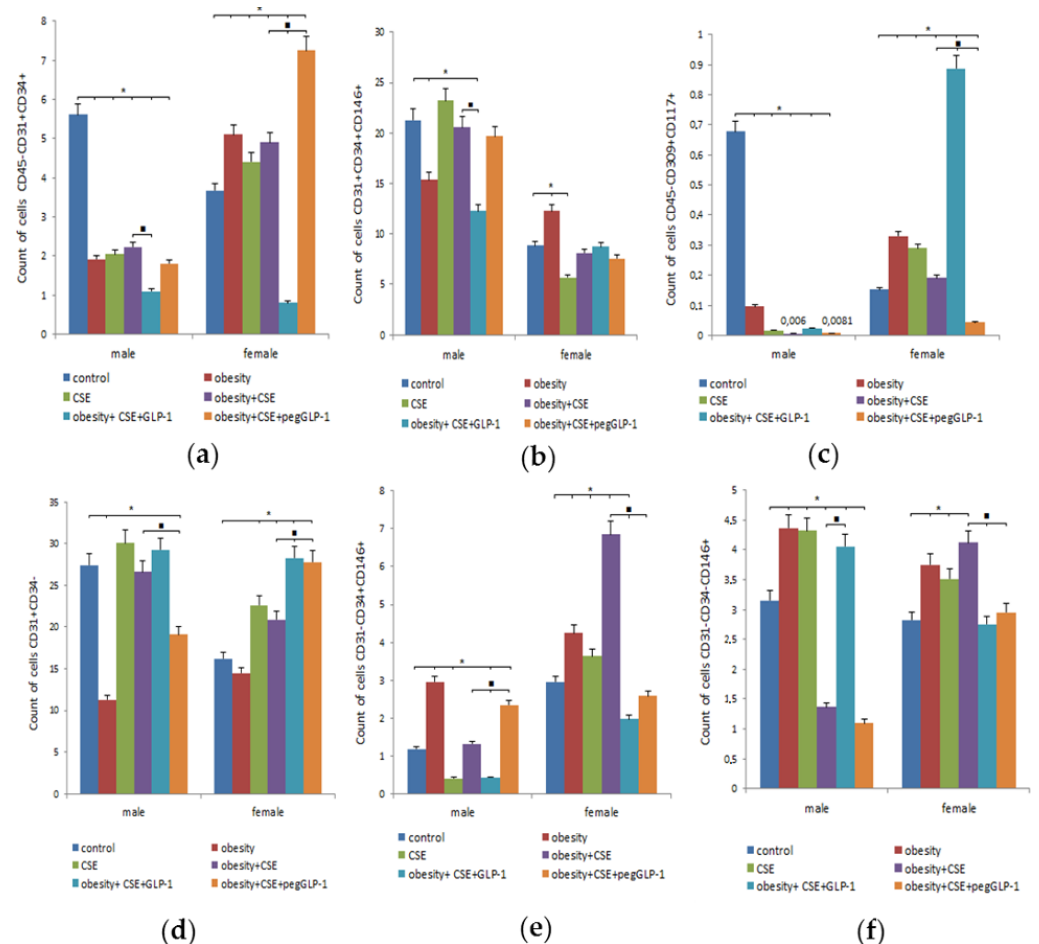
Figure 6. Characterization of cell population isolated from the lung of male and female C57BL / 6 mice on the p189. ( a ) The content of endothelial progenitor cells (EPC) (CD45 − CD31 + CD34 + ); ( b ) The content of EPC (CD31 + CD34 + CD146 + ); ( c ) The content of angiogenesis precursors (CD45 − CD309 + CD117 + ); ( d ) The content of cells in the lumen of the nascent vessel (CD31 + CD34 − ); ( e ) The content of vascular smooth muscle cells (CD31 − CD34 + CD146 + ); ( f ) The content of pericytes (CD31 − CD34 − CD146 + ). Cells were analyzed by flow cytometry using antibodies for CD31, CD34, CD45, CD146, CD117, CD309 mice. Dot plots are representative of three independent experiments with the mean from three independent experiments. Groups: control—a control group from intact mice, obesity—mice with metabolic disorders (MD) (obesity and hyperglycemia), CSE—mice with lungs emphysema, obesity + CSE—mice with MD (obesity and hyperglycemia) and lungs emphysema, obesity + CSE + GLP-1—mice with MD (obesity and hyperglycemia) and lungs emphysema treated with GLP-1, obesity + CSE + pegGLP-1—mice with MD (obesity and hyperglycemia) and lungs emphysema treated with pegGLP-1. *—significance of di ff erence compared with control ( p < 0.05); (cid:4) —significance of di ff erence compared with the obesity + CSE group ( p <